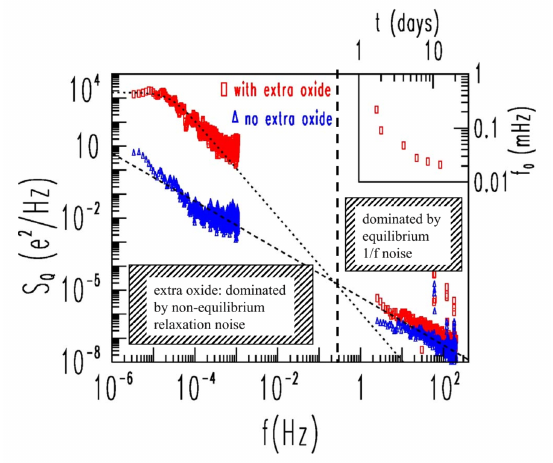
Figure 5. Power spectral density of charge offset drift fluctuations for two metallic devices. The device which was encapsulated with oxide shows larger S Q at low frequency while the high frequency noise is similar. The blue curve also follows a 1/ f dependence at low frequencies indicating it is dominated by equilibrium noise. The inset shows the knee frequency as a function of the experimental run time. Data were obtained at a temperature of 25 mK. Reproduced with permission from reference [41], Copyright 2009, American Physical